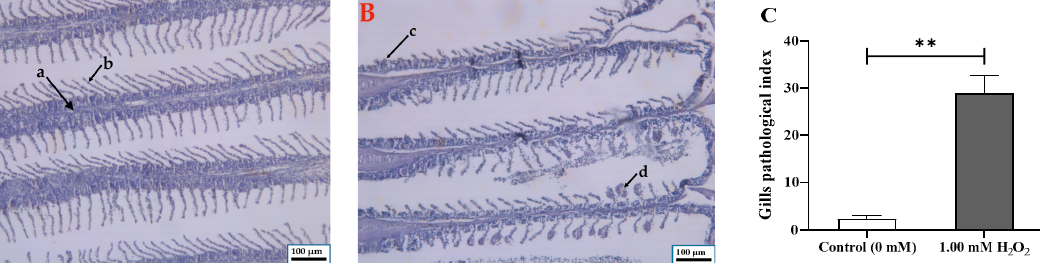
Figure 2. Histological alterations in gill of Cyprinus carpio . ( A ) Control group (a, gill arch; b, gill filaments); ( B ) 1.00 mM H 2 O 2 -exposed group (c, atrophy; d, hypertrophy); ( C ) gill pathological index (mean ± SE, n = 9). The sections were stained with H&E and observed at 100 × original magnification. Bar = 100 μ m. ** indicates significant difference between control group and H 2 O 2 -exposed group ( p < 0.01, t test).